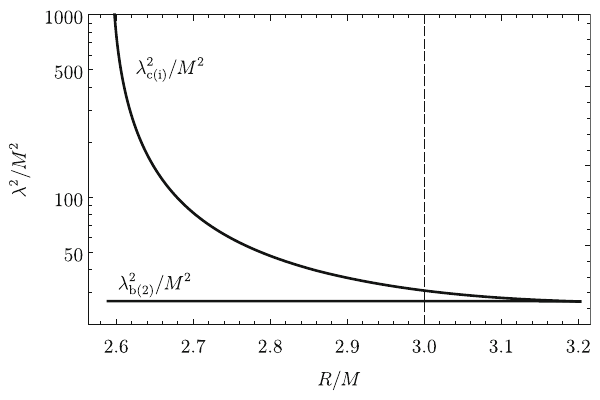
Fig. 4 Impact parameters governing the trapping cones of null geodesics in Tolman VII spacetimes. Dependence of the critical val- ues of the impact parameter, λ c ( i ) and λ b ( 2 ) is given as a function of the parameter R /